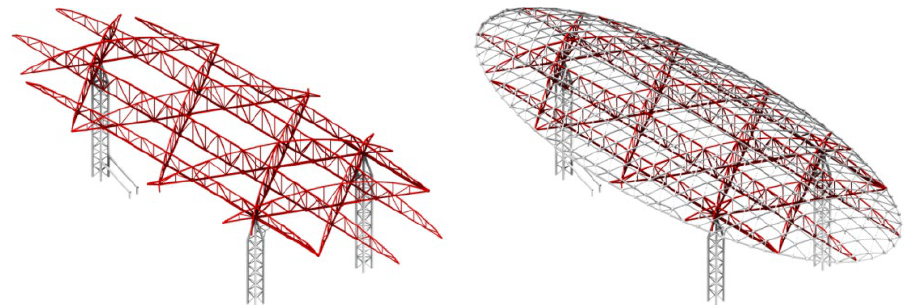
Figure 7. Truss structure.